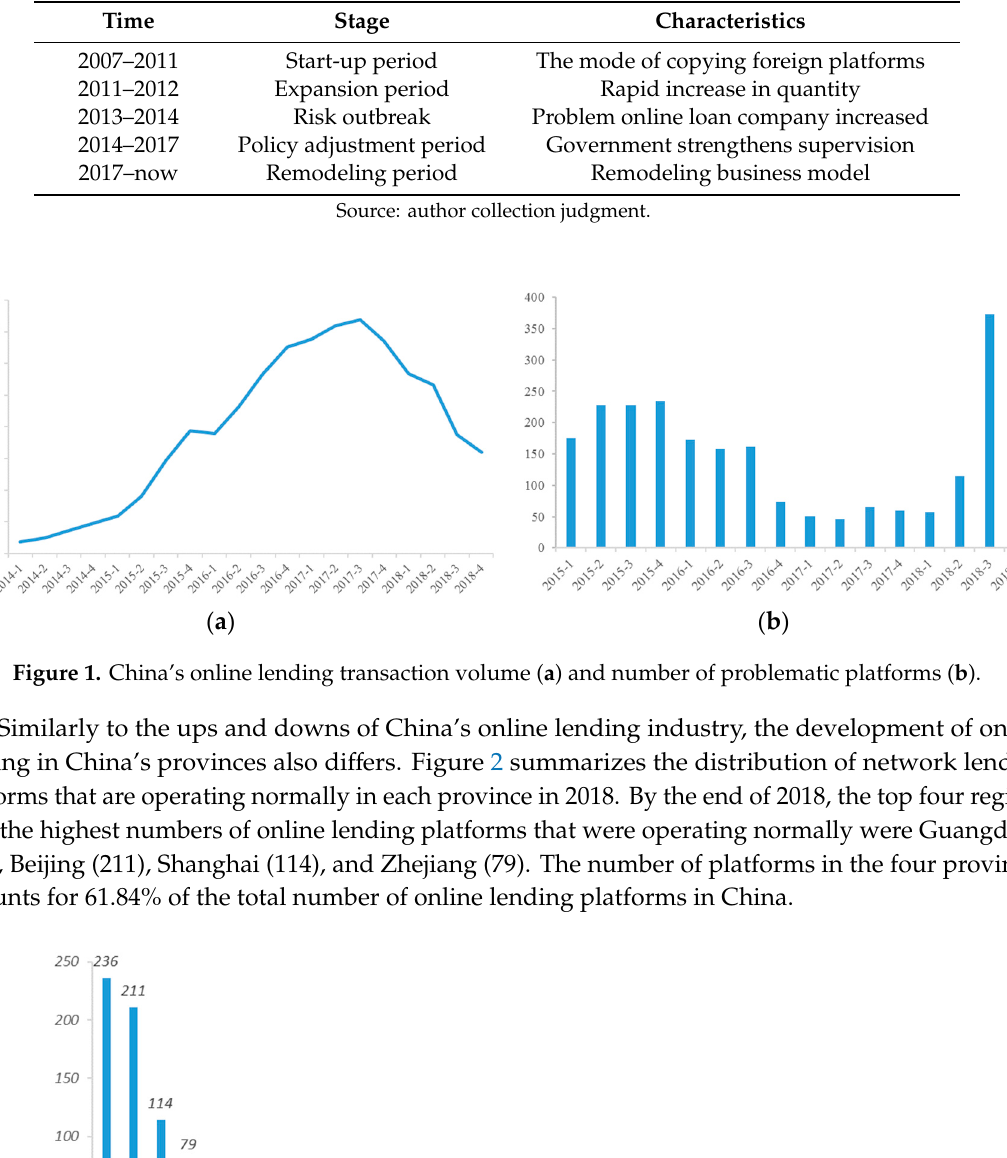
Table 1. Basic situation and stage division of China’s peer-to-peer (P2P) development.